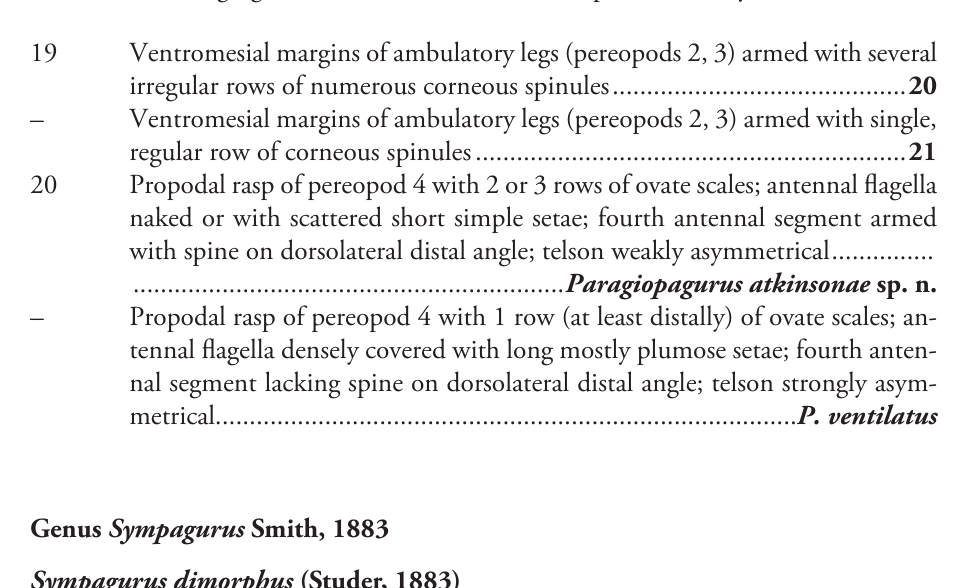
Primary synonyms: Eupagurus dimorphus Studer, 1883: 24, figs 11, 12 (type locality: South Atlantic Ocean, South Africa, off Cape of Good Hope, S.M.S.